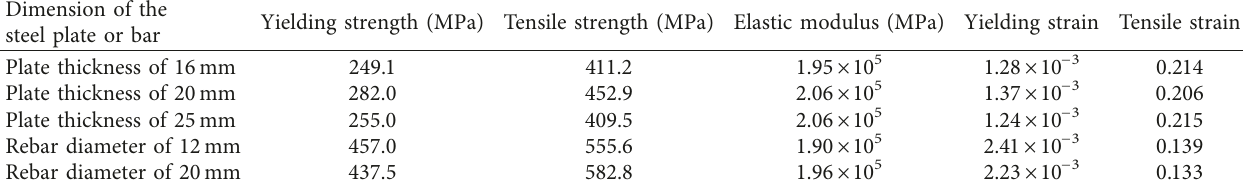
Table 2: Tensile test results of the encased steel plate and steel bar.